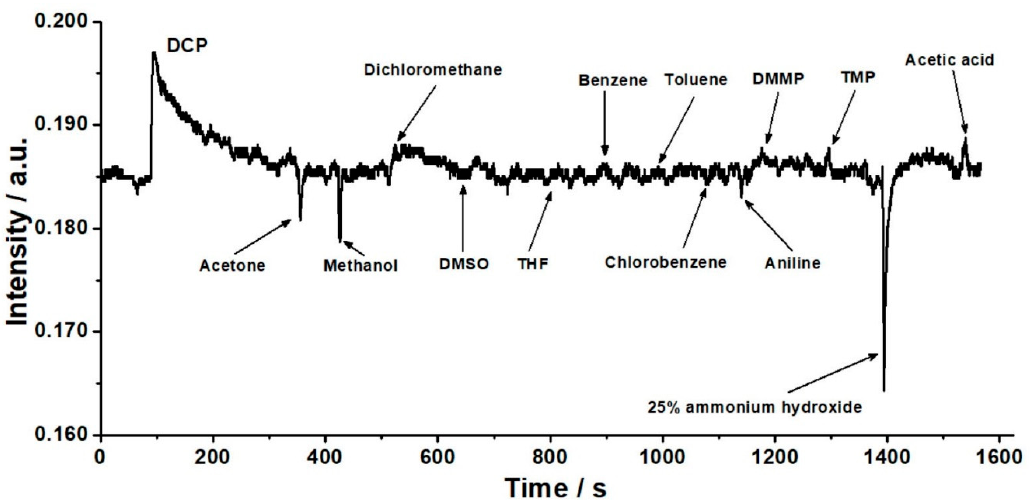
Figure 9. Selective response to saturated steam of various gases and 26.32 × 10 − 6 volume fraction of the DCP vapor.